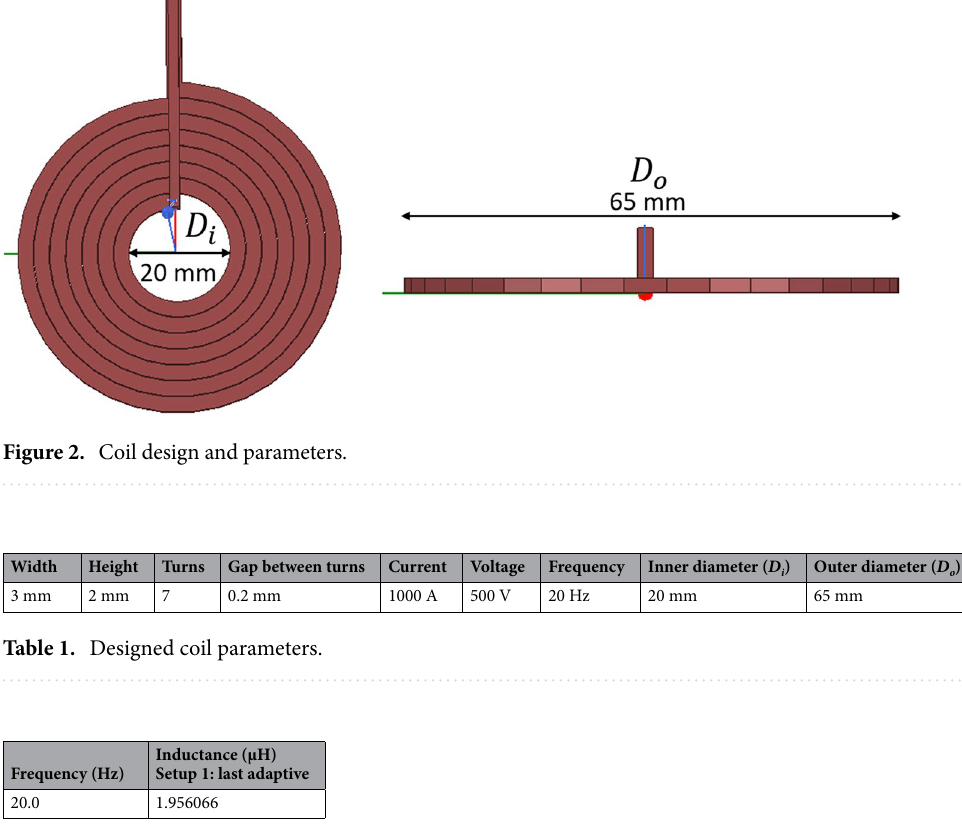
Table 2. Inductance of the designed coil.